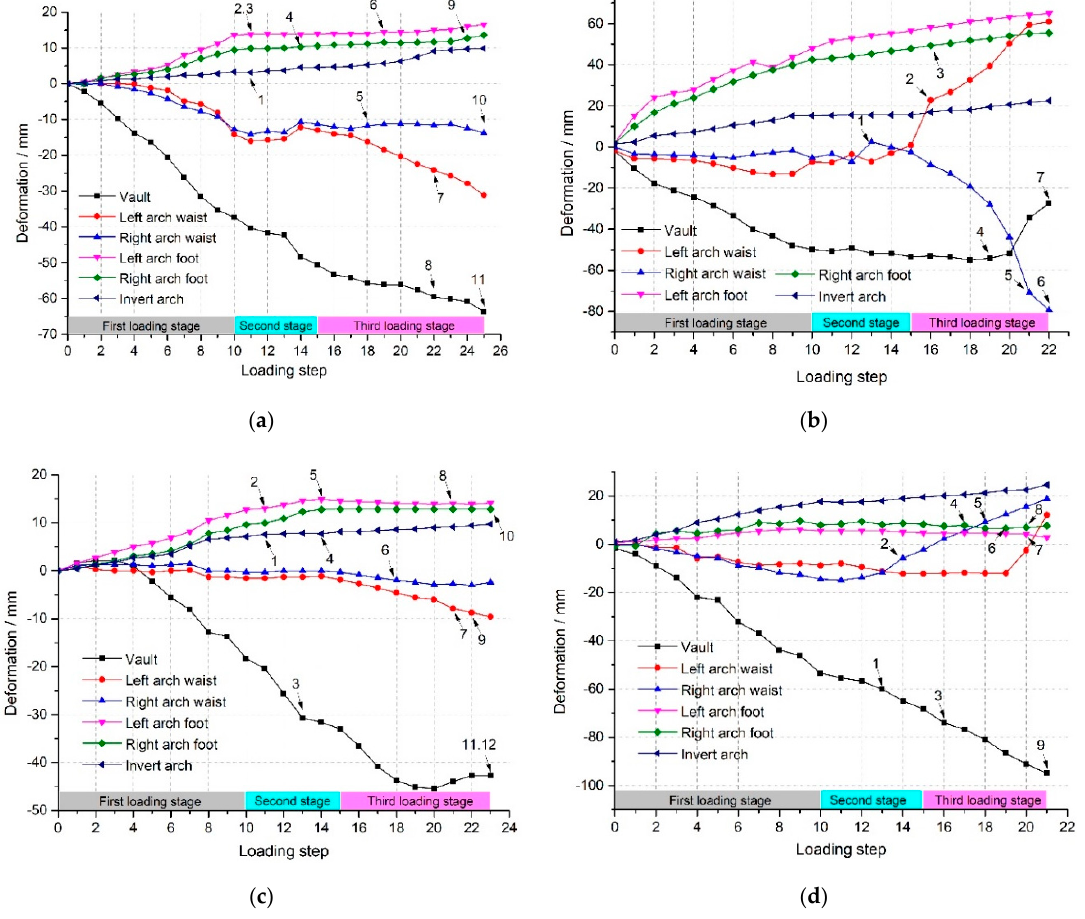
Figure 15. Deformation development curve of secondary lining. ( a ) Case 1, ( b ) Case 2, ( c ) Case 3, and ( d ) Case